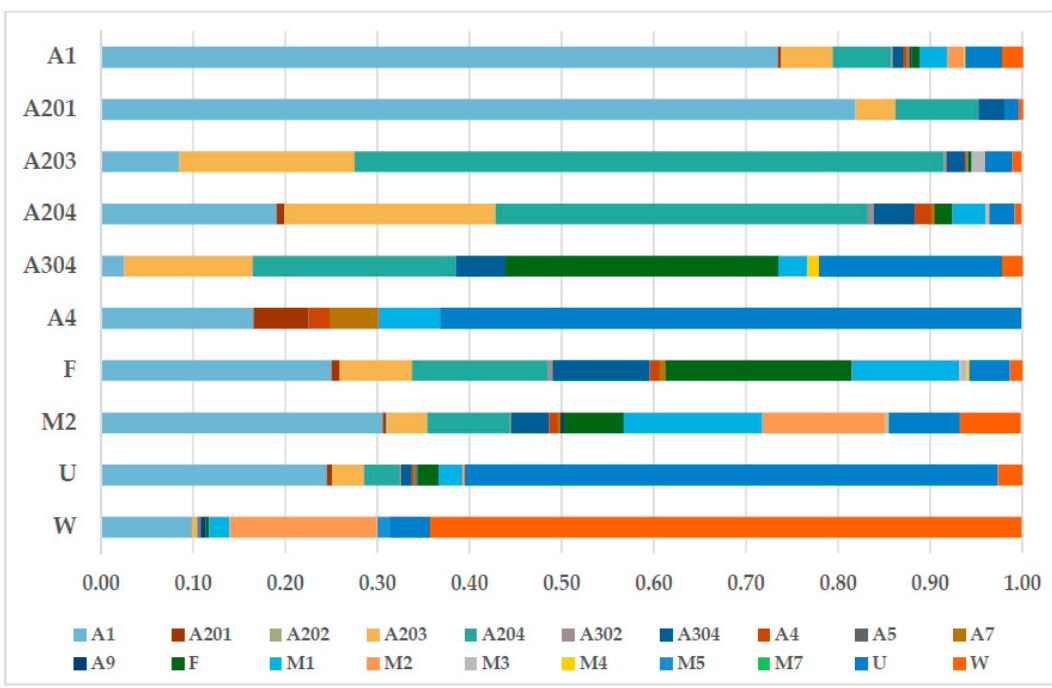
Figure 10. Proportions of land-use change during 2002–2017 in KLs area.